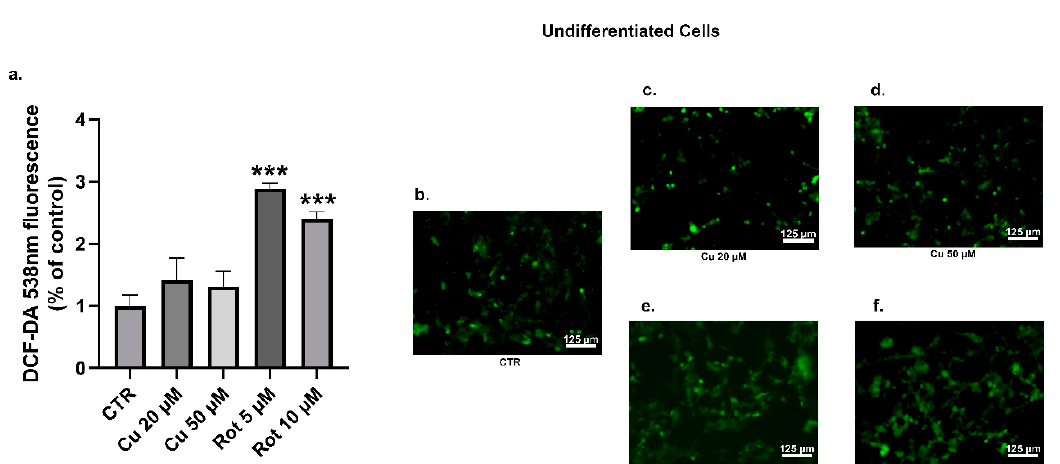
Figure 10. Undifferentiated SHSY5Y cells DCFDA analysis. The relative intensity of DCF was employed to evaluate the reactive oxygen species (ROS) levels. Cells were treated with 20 or 50 µ M copper ( c , d ) or 5 or 10 µ M rotenone ( e , f ) and compared to untreated cells ( b ). Fluorescence values were normalized on total protein ( a ). Values were compared with untreated cells (CTR) by one-way ANOVA following Tukey test *** p < 0.0002.